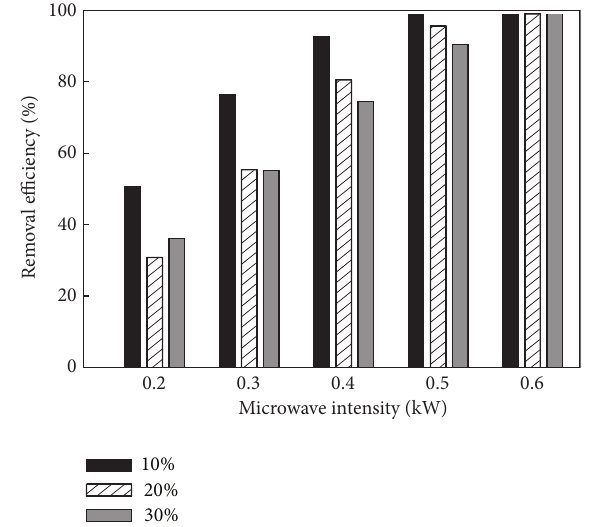
Figure 5: Effect of inlet concentration on photocatalytic removal efficiency of